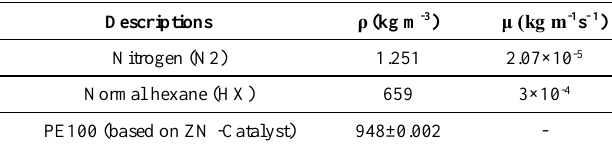
Table 1. Physical properties of industrial